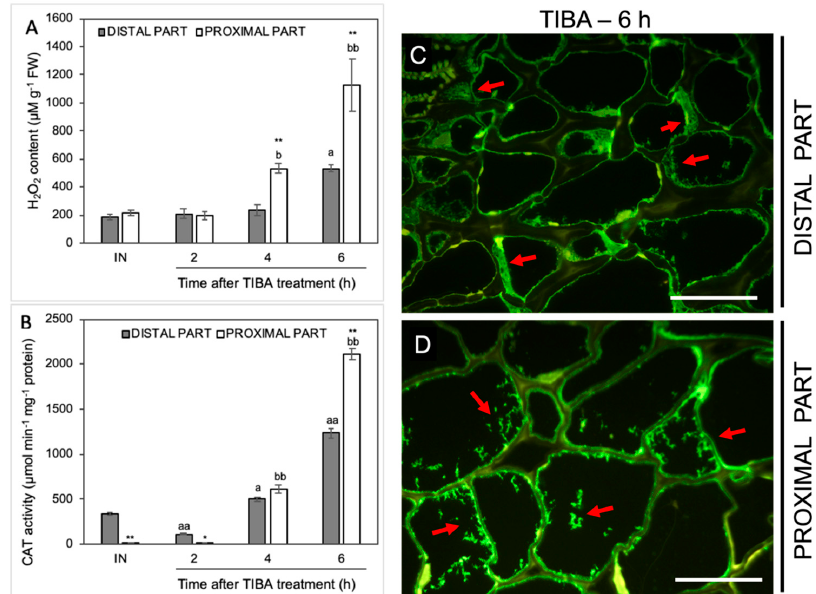
Figure 7. The level of H 2 O 2 and the activity and localization of CAT were altered in various regions of the AZ under the influence of a polar auxin transport inhibitor. Tween 20 solution (0.05%) was applied directly to the inactive AZ (IN) and material was collected after 8 h. An inhibitor of polar auxin transport, namely 2,3,5-triiodobenzoic acid (TIBA, 0.05 mM in 0.05% Tween 20), was also applied to the IN AZ and tissues were excised 2, 4, 6, and 8 h after the treatment. The samples were used for the determination of H 2 O 2 content ( A ) and catalase (CAT) activity ( B ). Values are presented as the mean of three biological replicates. Error bars indicate SEs. t -test: ** p < 0.01 and * p < 0.05, distal versus proximal part; aa p < 0.01 and a p < 0.05, treated distal part versus inactive distal part; bb p < 0.01 and b p < 0.05, treated proximal part versus inactive proximal part. The localization of CAT was performed using the specific antibody in the distal ( C ) and proximal ( D ) area of the flower AZ. Observations were carried out 6 h after the TIBA application. The green fluorescence signal marked by red arrows indicates the CAT presence. Scale bars: 40 µM.